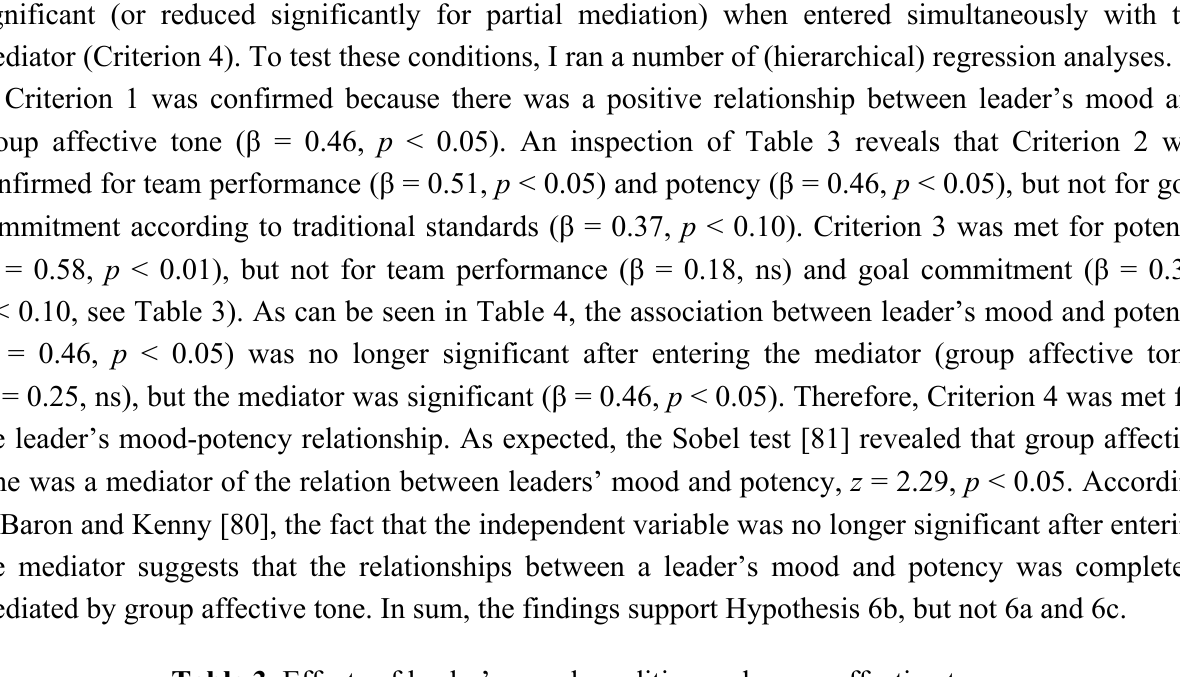
Table 3. Effects of leader’s mood condition and group affective